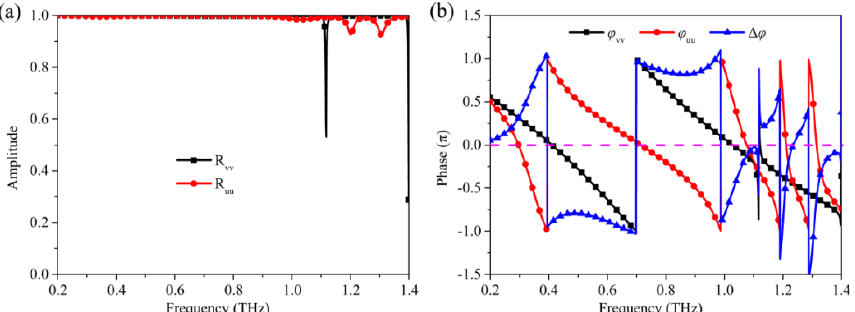
Figure 7. The simulation results of incident u - and v -polarization wave. ( a ) Reflection spectra, ( b ) Phases.